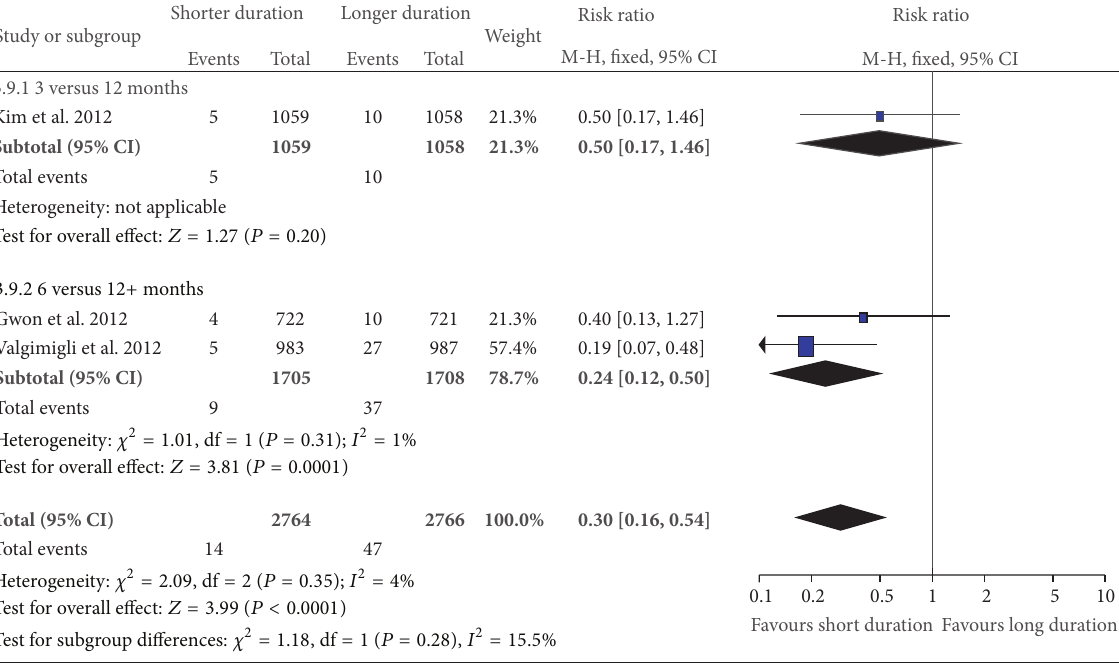
Figure 4: Risk of mortality and